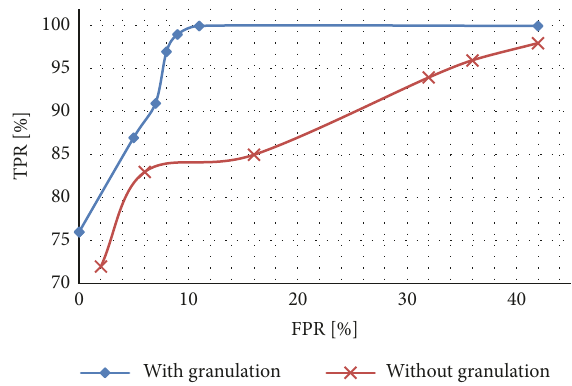
Figure 6: ROC curves for the Chi-Square metric comparing effectiveness of anomaly detection when granules for payload are extracted and otherwise. The experiment conducted for an algorithm trained on 32000